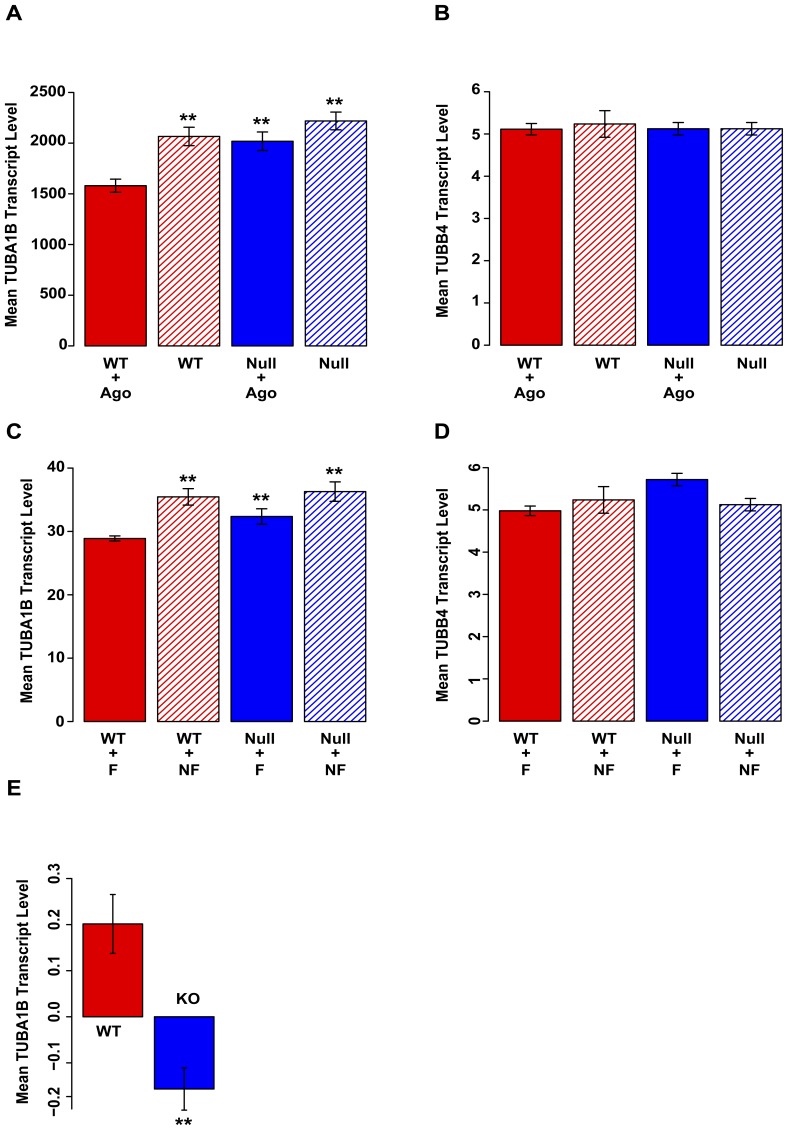
PPARA and RORA regulate TUBA1B expression.For all figures, n = 3 per bar. (A) Effects of PPARA genotype (wild-type = red, null = blue) and PPARA agonist WY14643 (present = filled, absent = dashed) on TUBA1B expression in murine small intestine. Error bars, standard error of the mean. (**, P<0.01 compared to wild-type + agonist condition). Only PPARA wild-type mice receiving the PPARA agonist show a reduced TUBA1B expression. Data from [35]. (B) PPARA genotype and PPARA agonist do not affect TUBB4 expression. Data from [35]. (C) PPARA genotype and fasting (PPARA activation, fasting = filled, no fasting = dashed) effects on TUBA1B expression in murine small intestine (**, p<0.01 compared to wild type + fasting condition). Only PPARA wild-type mice that fasted show reduced TUBA1B expression. Data from [35]. (D) PPARA genotype and fasting do not affect TUBB4 expression. Data from [35]. (E) RORA activates TUBA1B expression in murine skeletal muscle (**, p<0.01). Data from [36]. All ordinates on log2 scale, except (E), which is log10.